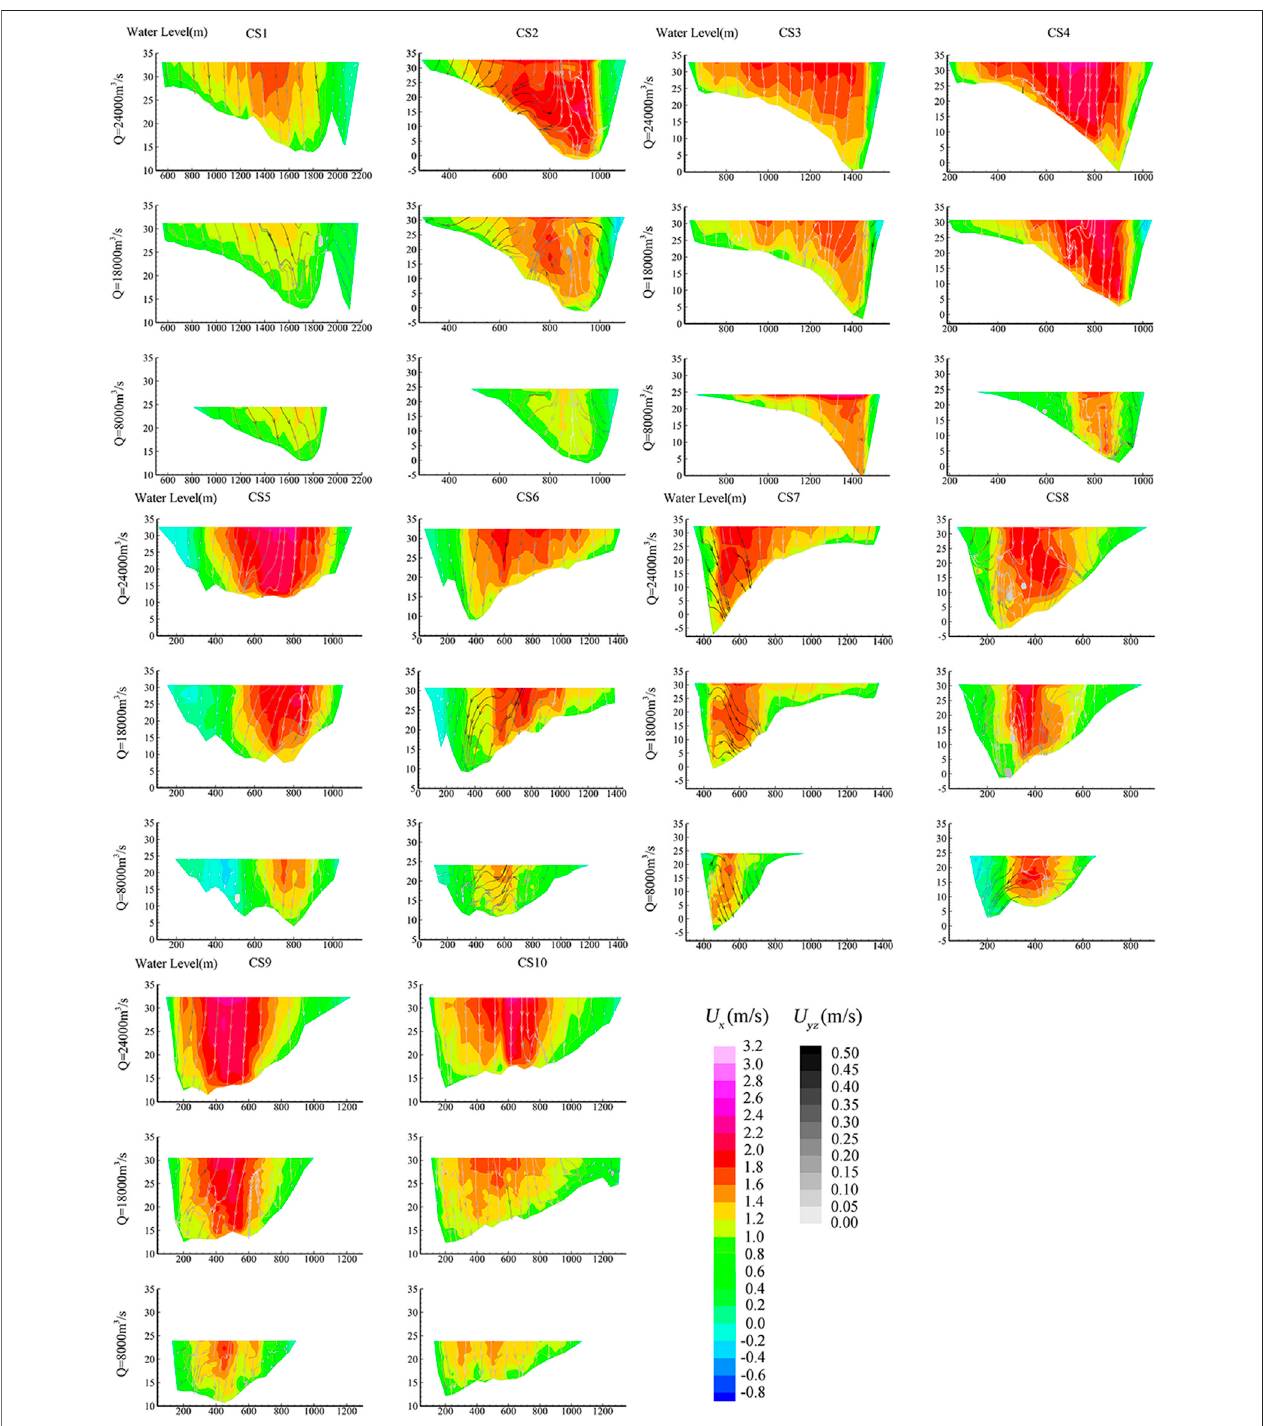
FIGURE6| The fl owdistributionon Bend A and Bend B. Thestreamwise fl owvelocity ( U x ) isshown withacontour map, and the isoline interval is0.2 m/s, ranging from − 0.8 to 3.2 m/s. The cross-stream velocity ( U yz ) is shown with streamlines and the value of gray scale represents the velocity magnitude, ranging from 0.00 to 0.50 m/s.Especially,the “ shallowshoal ” referstothatpart(above24 m)oftheconvexbankthatwillbeexposedduringlowwater,andthe “ deepshoal ” referstothatpart (under 16 m) of the convex bank that is always submerged, while the “ middle shoal ” refers to that part of the convex bank that is in between “ shallow shoal ” and “ deep shoal ” in this